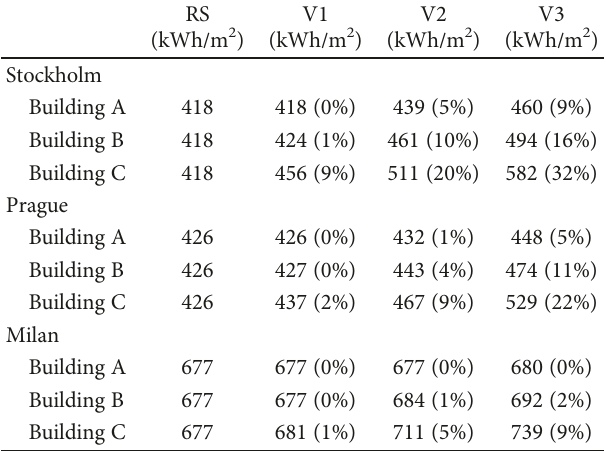
Table 6: The simulation results of the annual solar energy yield of the compared